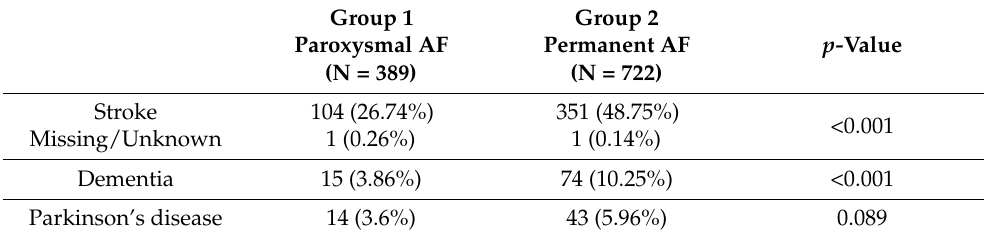
Table 2. Presence of stoke, dementia, and PD among the two study groups.